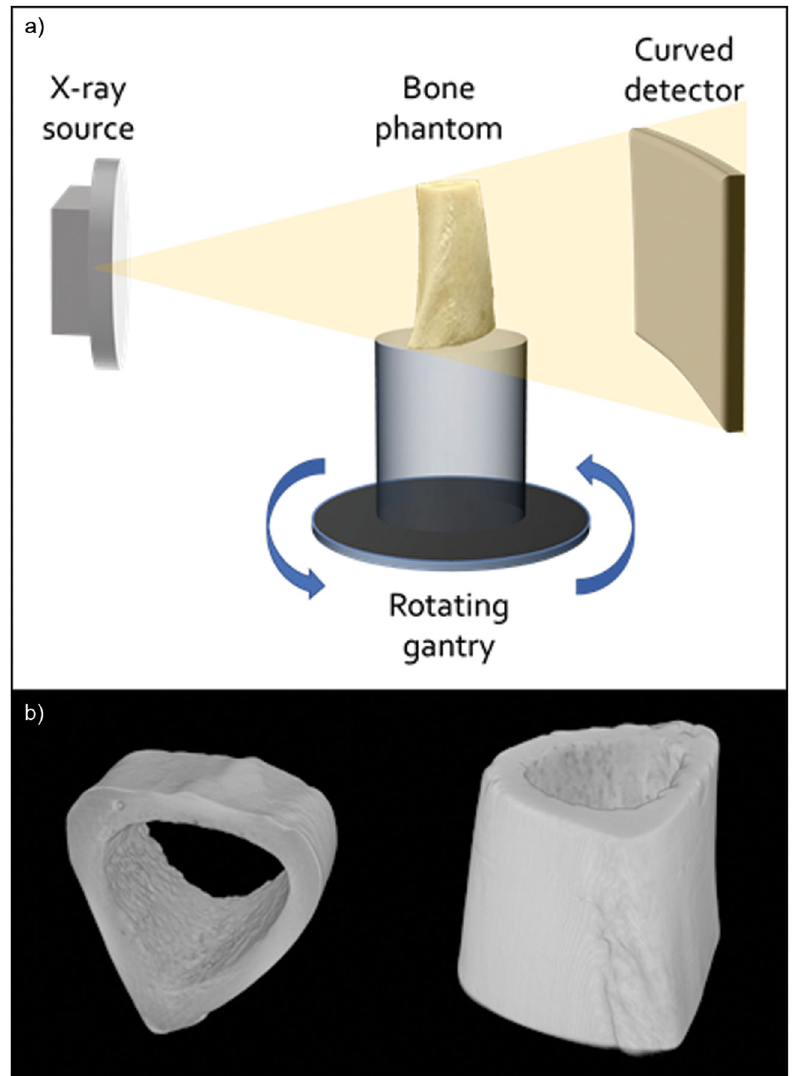
Fig. 7 3D X-ray characterization. a Schematic of CBCT test bench used for characterization of the curved digital X-ray detector, showing X-ray source, bone phantom, and curved digital X-ray detector. b Reconstructed 3D images of the bone